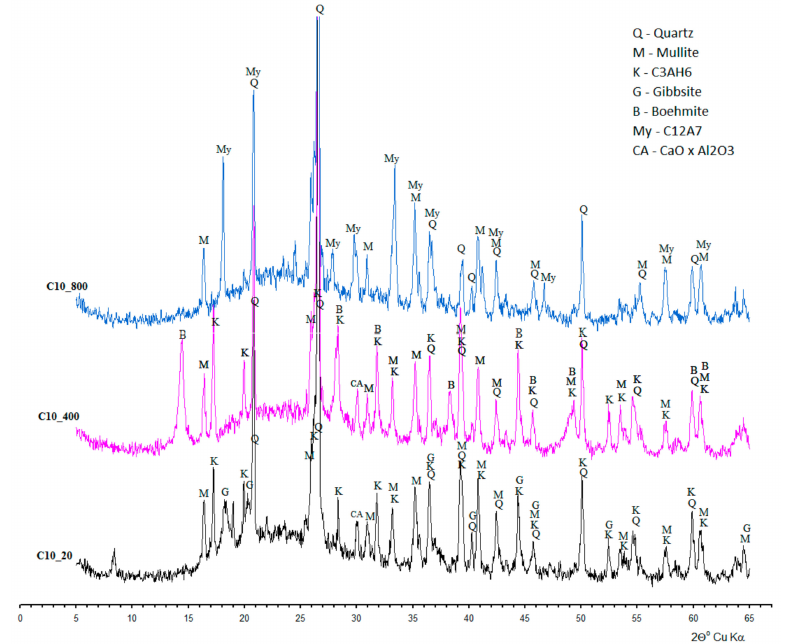
Figure 5. Diffractograms of mineral content of examined concretes containing calcium aluminate